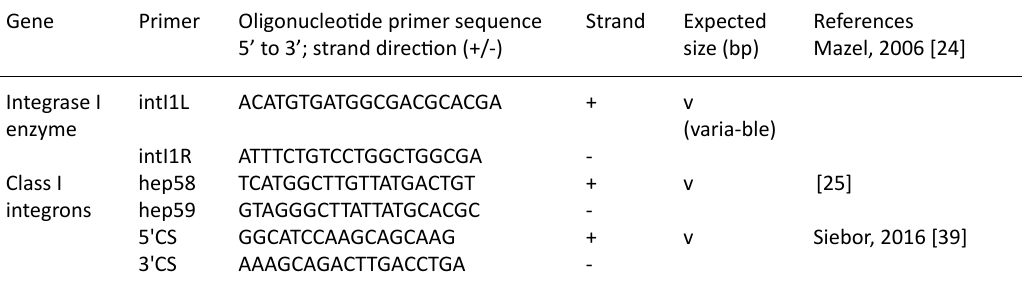
Table 2. Primers for the detection of class 1 integrons Gene Primer Oligonucleotide primer sequence